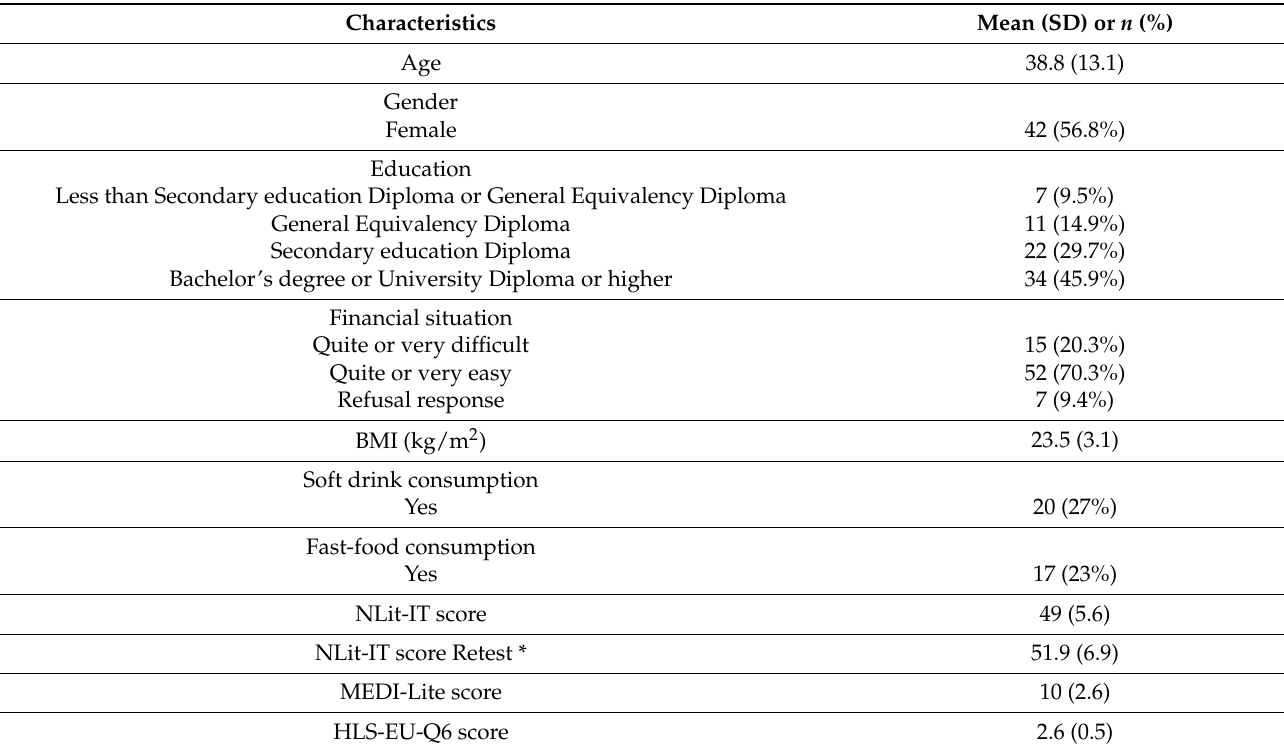
Table 1. Characteristics of the sample that participated in validity testing of Nutrition Literacy Assessment Instrument for Italian Subjects (NLit-IT) ( n =